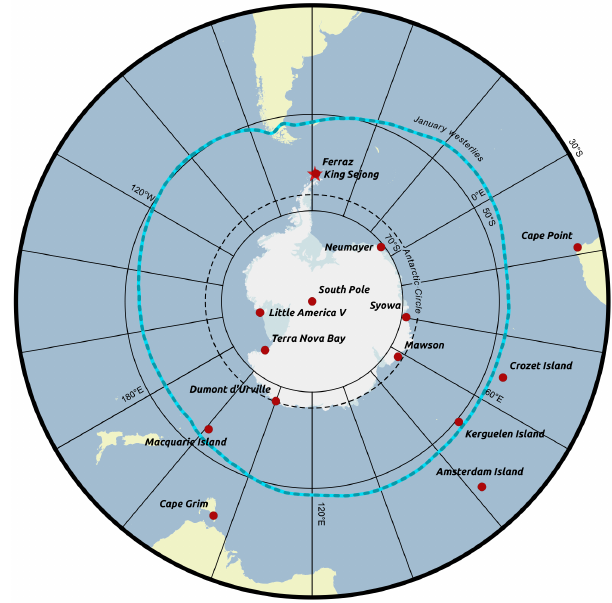
Figure 1. Overview of historic and current atmospheric radon mea- surement sites in Antarctic and sub-Antarctic regions, including King Sejong station, Antarctic Peninsula. Mean track of summer westerly winds indicated in